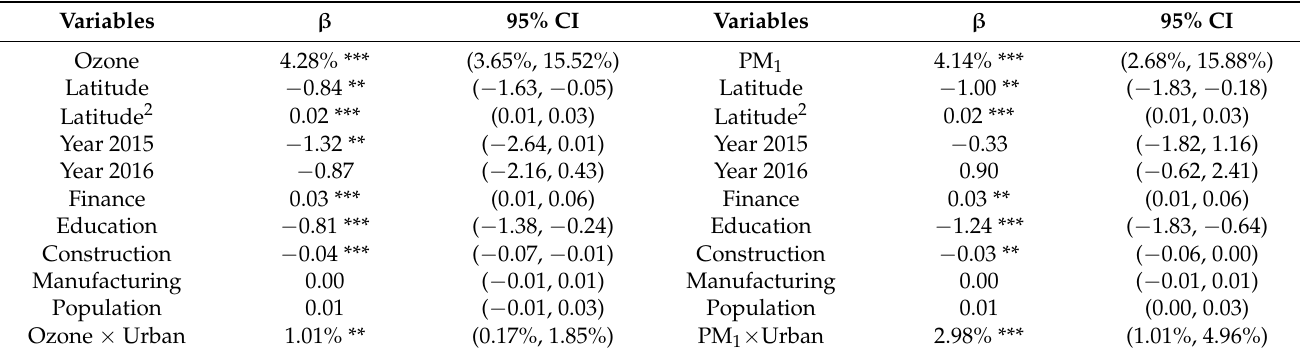
Table 7. Urban–rural modification effects on the association of health outcome with ozone and PM 1